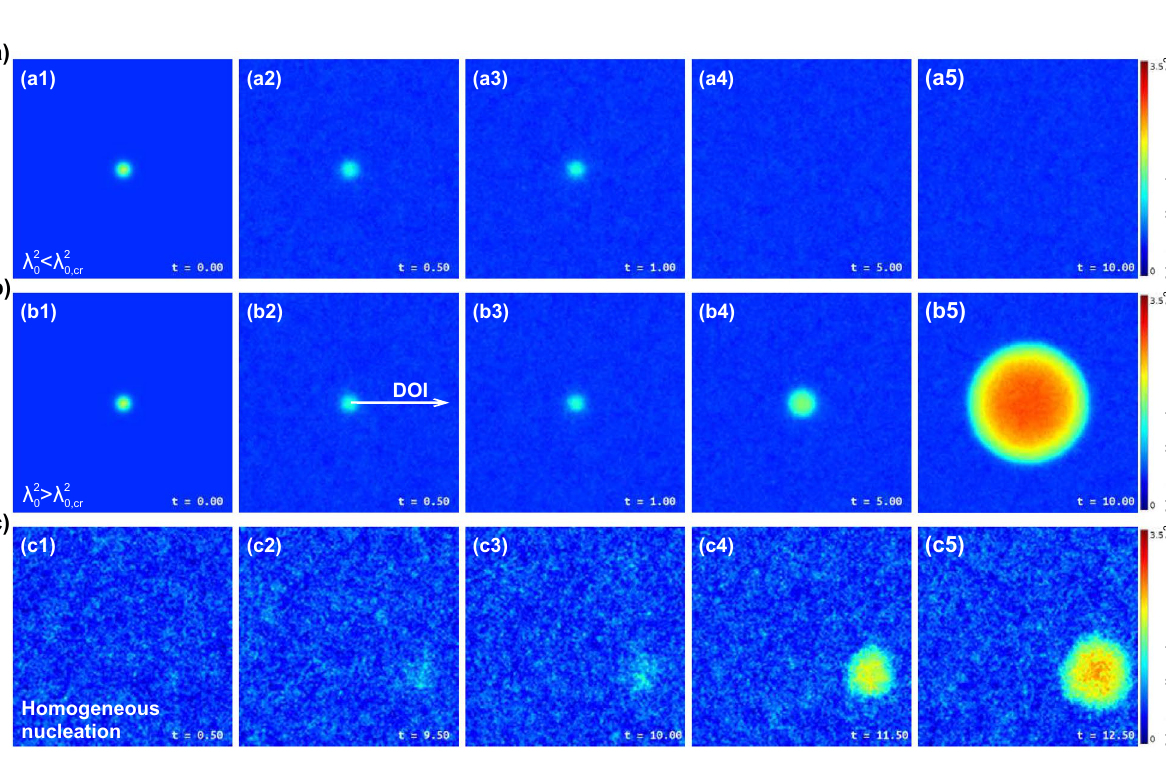
Figure 7. Evolution of different initial 3D (spherical) (cid:31) 2 -fluctuations (nuclei), and spontaneous nucleation in homogeneous system: sequential frames illustrate the evolution of ( a ) subcritical and ( b ) supercritical (cid:31) 2 -fluctuation (nuclei), and ( c ) spontaneous nucleation due to thermal noise (see also Supplemental Movie